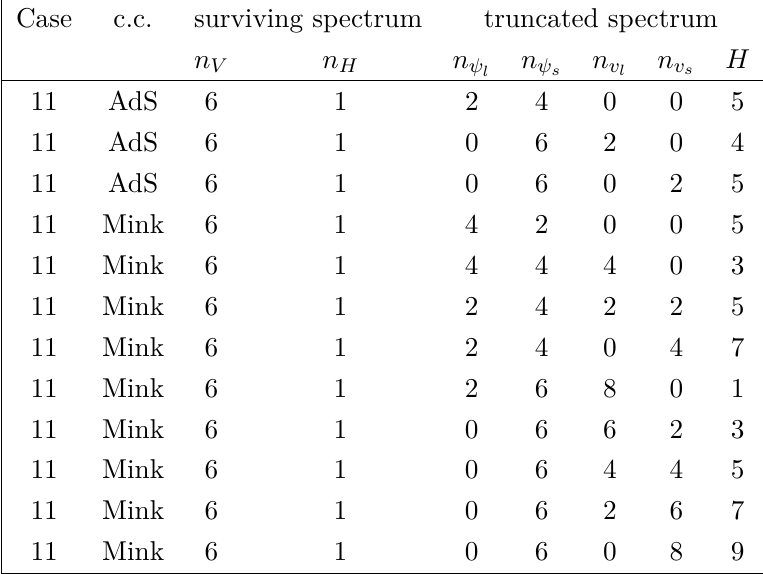
Table 9 . Supersymmetry breaking patterns and truncation of the spectrum — case